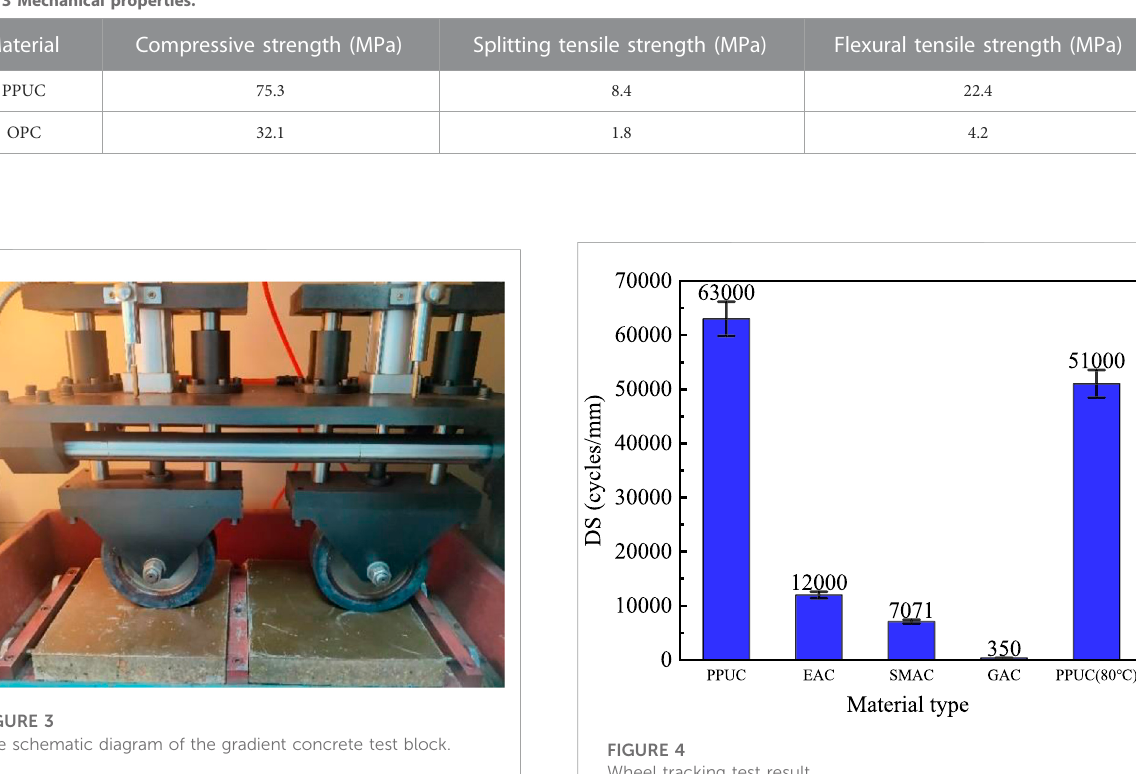
Wheel tracking test